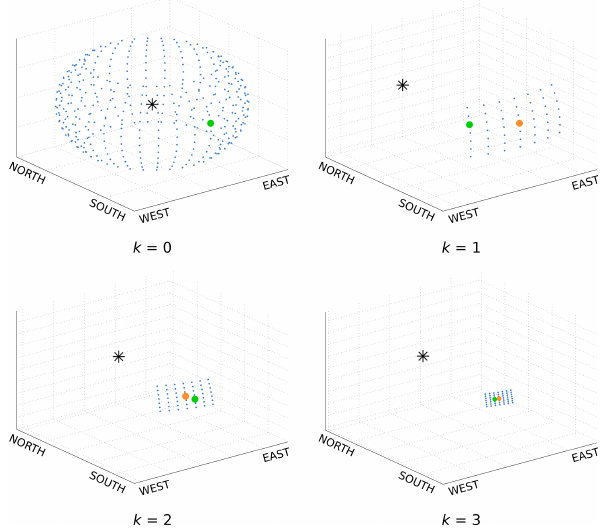
Figure 7. Viewing directions (blue points) of a camera (aster- isk) during image-to-DEM registration. The green dots indicate the viewing directions with the best score, and the orange dots indi- cate the best viewing directions of the previous scale. An exam- ple is shown for vertical and horizontal rotations from scale k = 0 to k =